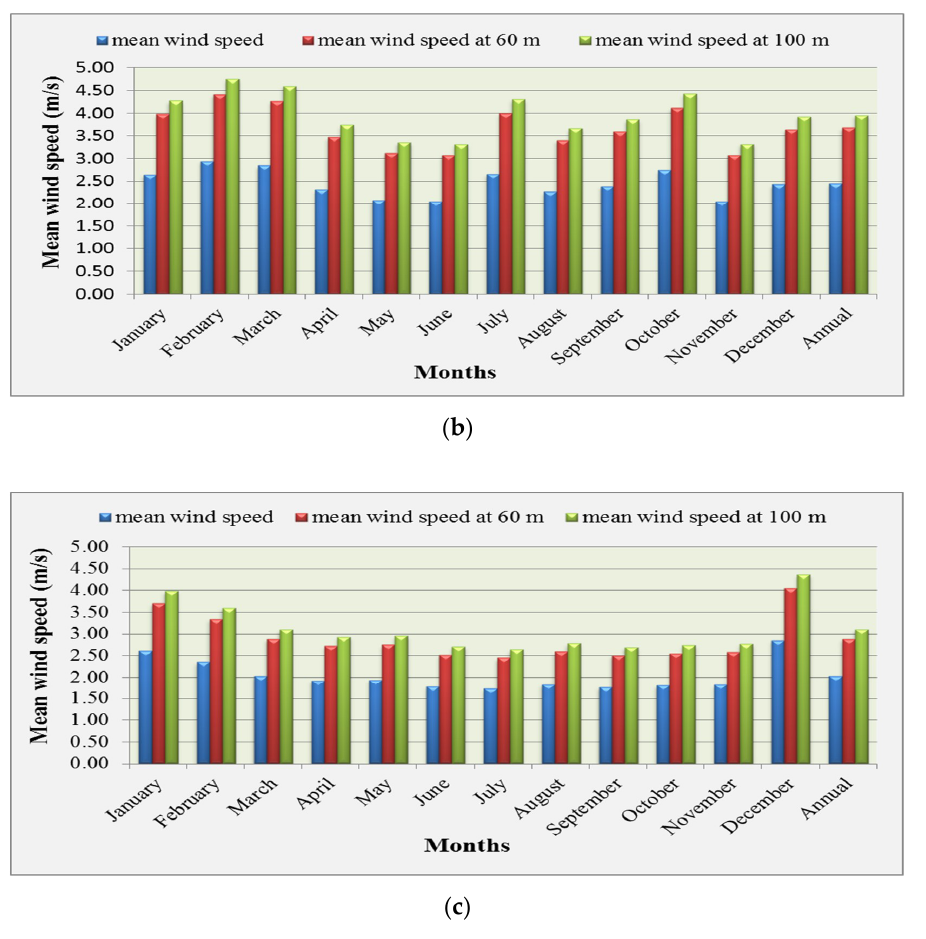
Figure 6. Monthly and annual mean wind speeds at sites ( a ) Mersing, ( b ) Kudat, and ( c ) Kuala Terengganu.